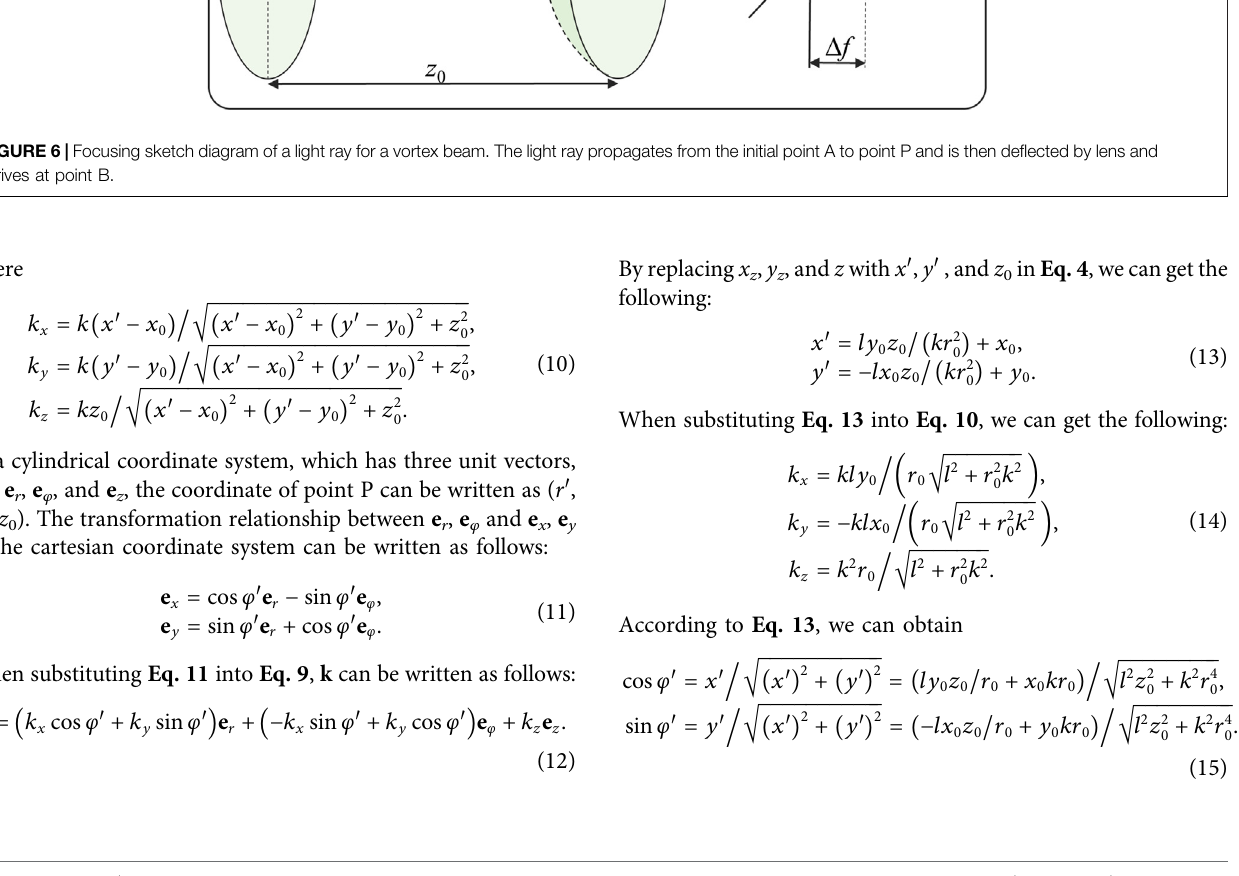
Frontiers in Physics |